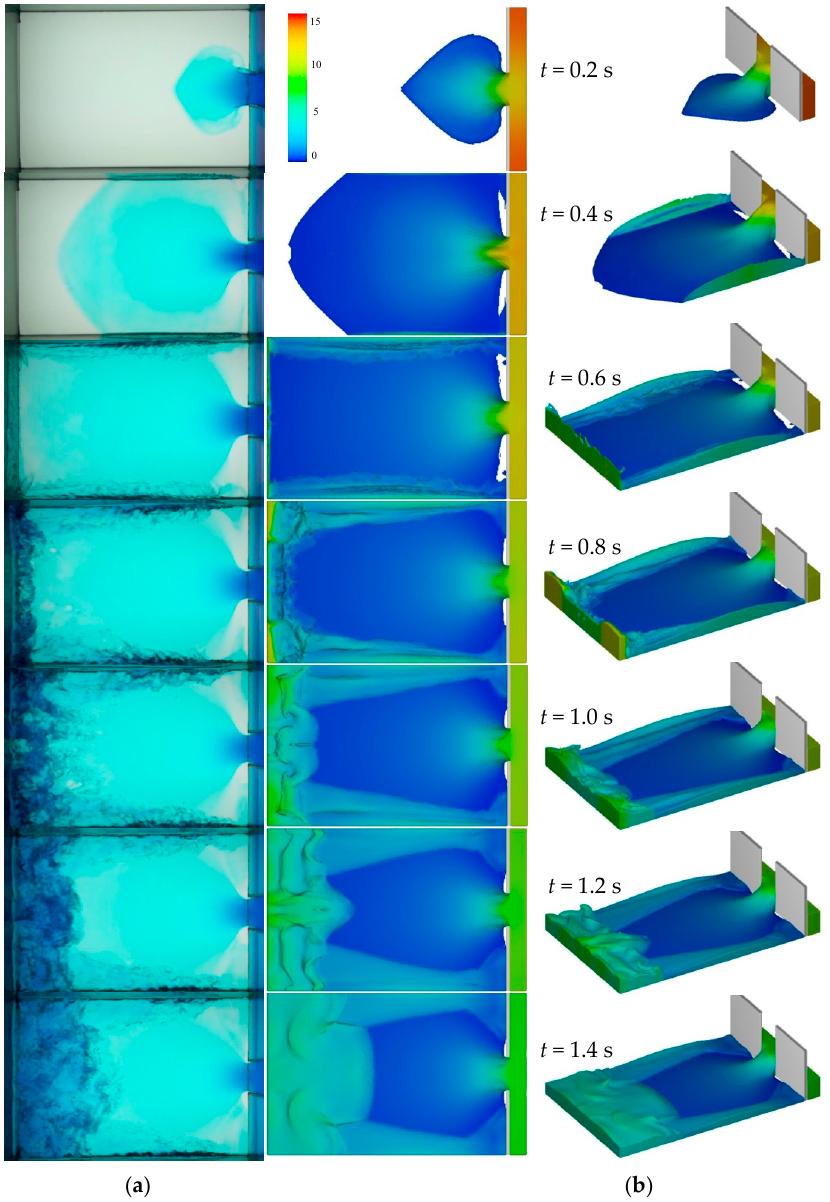
Figure 6. Comparison between experimental ( a ) and numerical results ( b ) for test D1 ( α = 0). A comparison of the stage hydrographs for the test case W1 is shown in Figure 9. After the fast removal of the sluice gate, water in the reservoir hit the tailwater and the flood wave moved downstream rapidly with a plunging type wave breaking that caused a complex flow behavior on the free surface. Significant fluctuations were observed on the surface with reflection phenomena of propagating waves from the side and the front-end wall of the channel, while also interacting with the incoming flow. It can be said that with the presence of the tailwater, more undulation occurred than D1 at all probes. The water level decreased quickly with the abrupt removal of the gate, and fluctuations occurred when the negative wavefront reached the P1. It can be noticed that the water depths pre- dicted by the RANS simulations were lower than the experimental results for the time